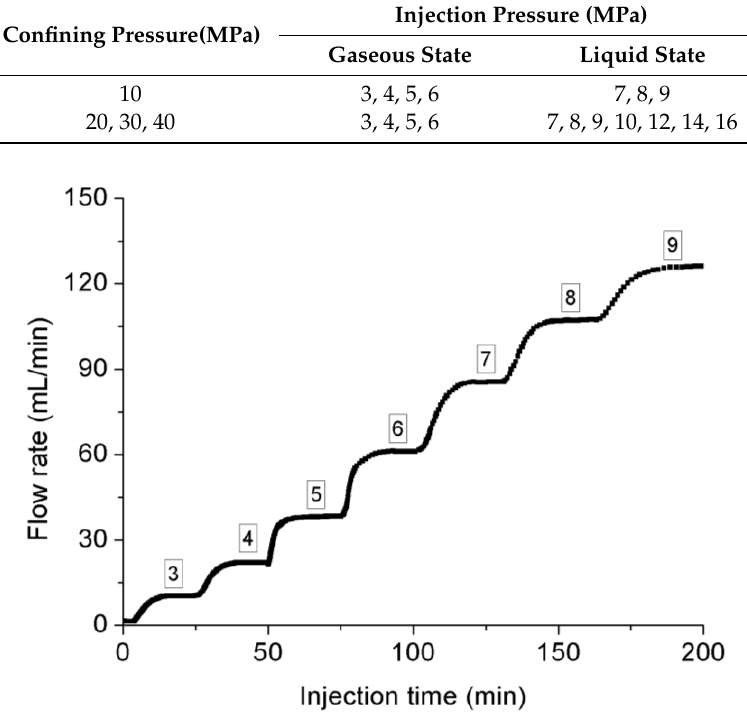
Figure 6. Flow rate development with time when injection pressure is not higher than 9 MPa.